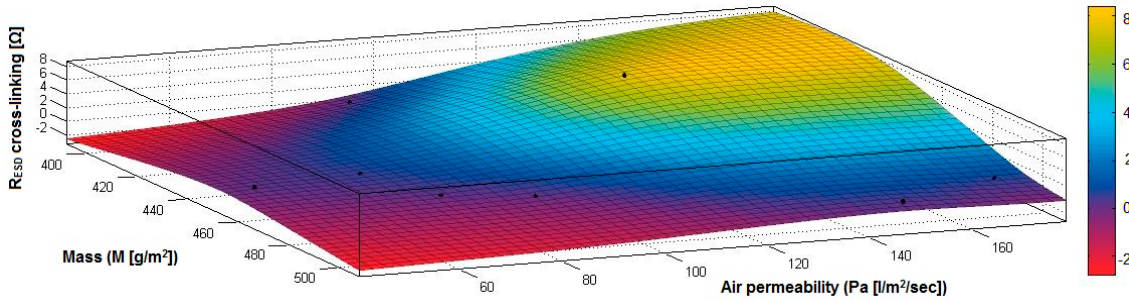
Figure 31. 3D representation R ESD after crosslinking = f(M, Pa) samples preliminarily treated in RF plasma O 2 using RF 1 generator and power 200 W.